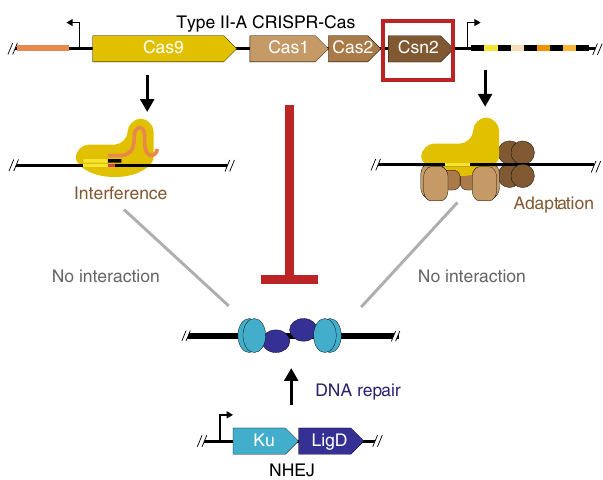
Fig. 5 Graphical summary of the results. Three possible modes of negative interactions between type II-A CRISPR-Cas systems and NHEJ systems were tested: NHEJ could block CRISPR interference, NHEJ could block CRIPSR adaptation, or CRISPR could block NHEJ repair. The last hypothesis was shown to be correct and Csn2 to be responsible for the inhibition of NHEJ